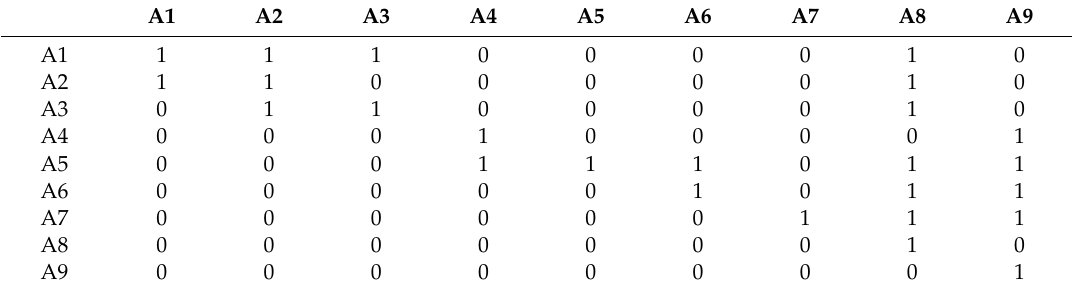
Table 8. The reachable matrix.